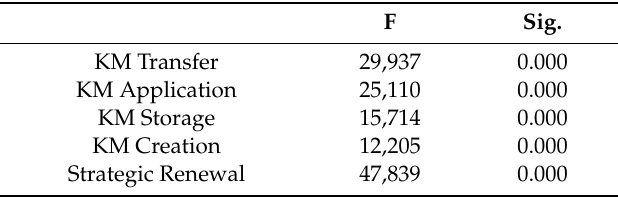
Table 4. Analysis of variance (ANOVA) test results.